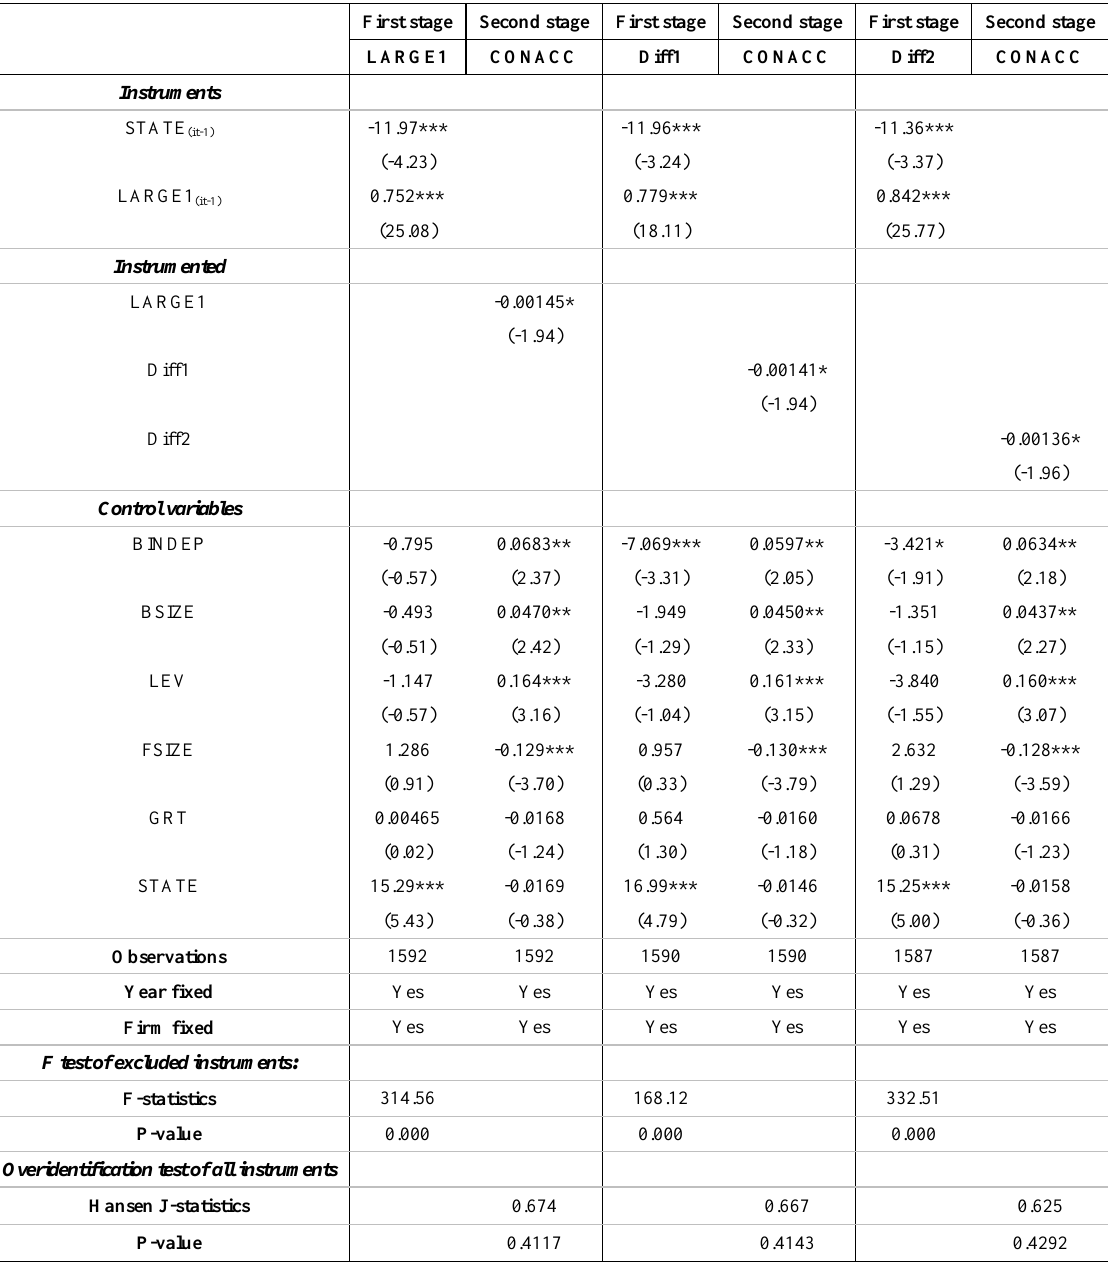
Table 6. Fixed-effects instrumental variables